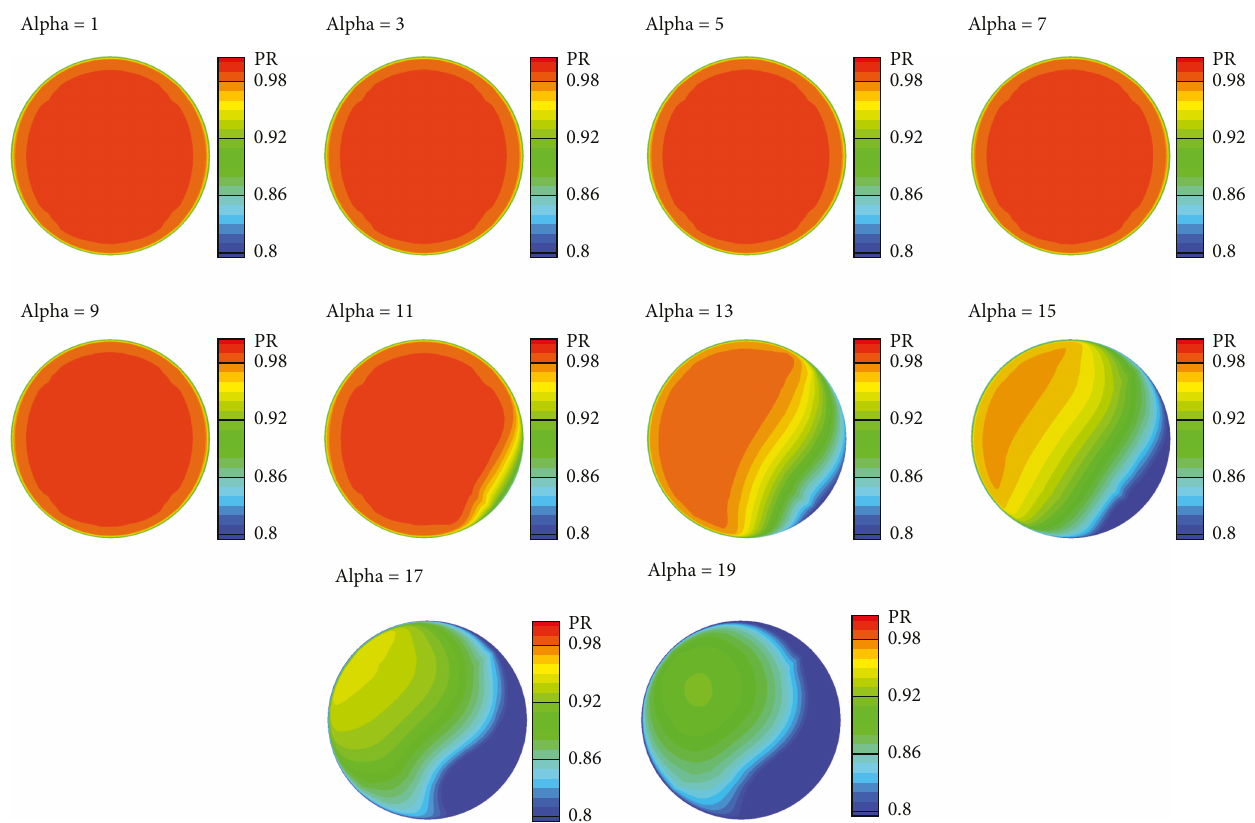
Figure 26: The inlet distortion of the BWB300 at di ff erent attack angles (low